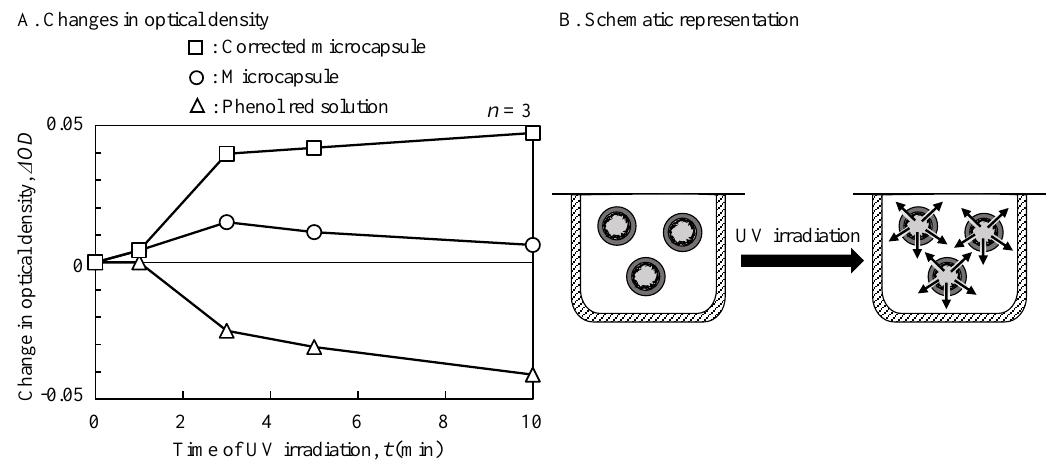
Figure 5. Time-course changes of optical densities for UV irradiation (wavelength 430 nm). OD—change rate of the optical density. ( A ) Changes in optical density; ( B ) Schematic representation.